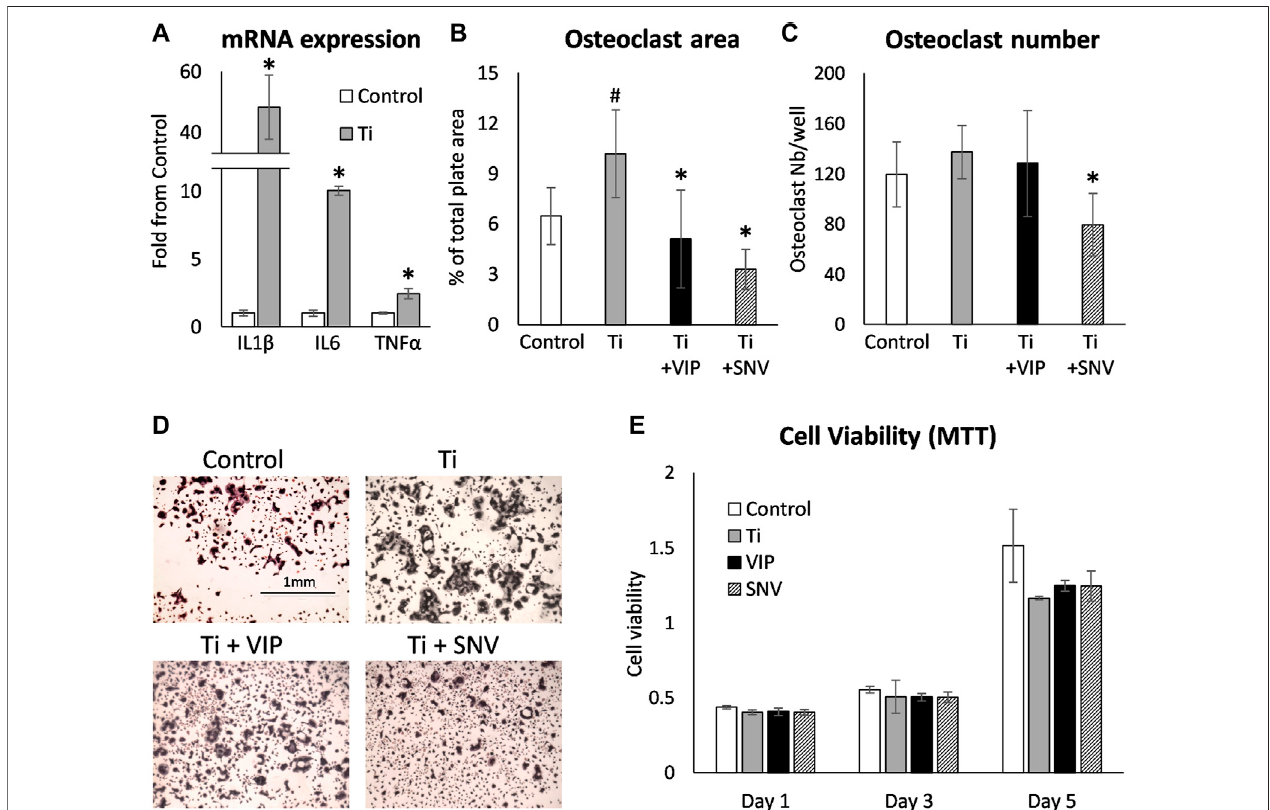
FIGURE 4 | VIP and SNV alleviate the osteoclastogenic effect of TiP-induced in fl ammation. (A) Primary BMDM were exposed to TiP and RNA was collected after 24 h. mRNA expression are presented as Mean ± SD fold change versus Control. * p < 0.05 vs. Control. (B-D) Primary murine preosteoclasts were cultured in 20 ng/ml M-CSFand50 ng/mlRANKLfor48 h.Conditionedmediumfrommacrophages(Control)andmacrophagesexposedtoTiparticles(Ti,asinA)wasthenaddedtogether with10 -6 MofVIPorSNV(orsaline)for48 hbeforeTRAPstaining.DataareMean ± SDforosteoclast%surfacearea (B) andnumberperwell (C) . (D) Representative images all acquired at a 4x original magni fi cation. The scale bar for all images is in the upper left panel. n (cid:2) 8, # p < 0.05 vs. Control; * p < 0.05 vs. Ti, ANOVA. (E) Primary murinemacrophages/preosteoclasts werecultured in20 ng/mlM-CSFand Tiparticles, 10 -6 MofVIP or SNV,orsaline only.MTT viabilityassay wasperformed after 1,3 and 5 days and presented as optical density values. N (cid:2) 5, no statistical differences were found between the treatment groups. Data are Mean ± SD in arbitrary OD units.